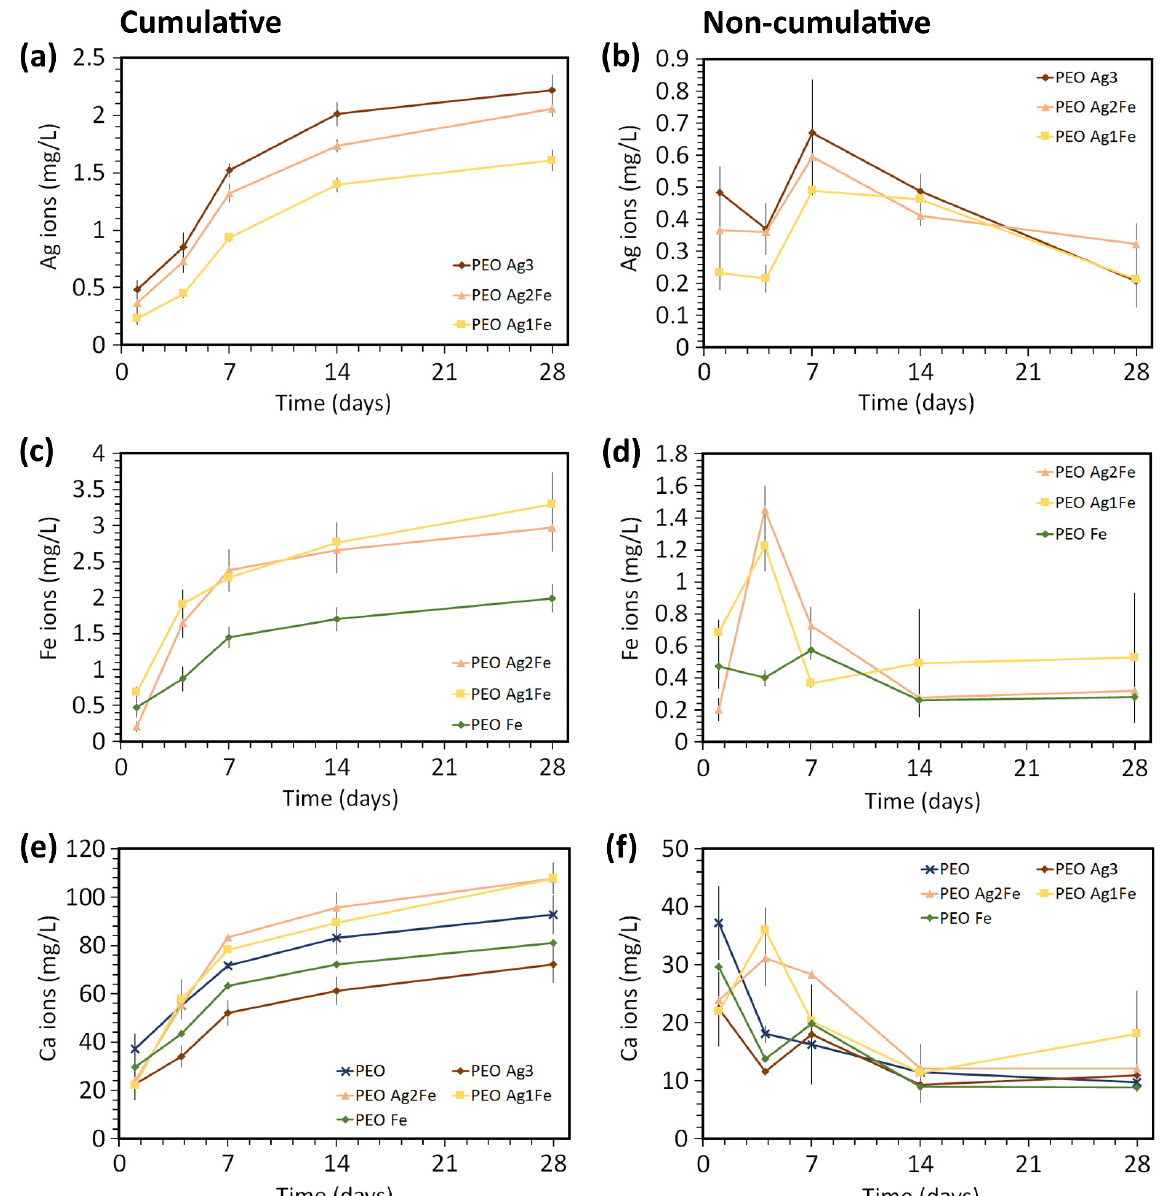
Figure 3. The ( a , c , e ) cumulative and ( b , d , f ) non-cumulative ( a , b ) Ag, ( c , d ) Fe, and ( e , f ) Ca ion concentrations released from the surface-biofunctionalized scaffolds during immersion over 28 days.